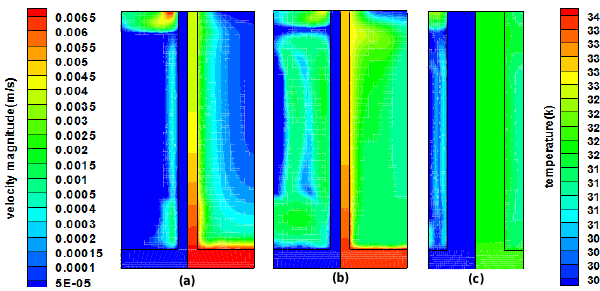
Figure 10. Temperature evolution and velocity fields: (a) case 6 and melt fraction of 0.1, (b) case 6 and melt fraction of 0.6, and (c) case 9 and melt fraction of 0.6.